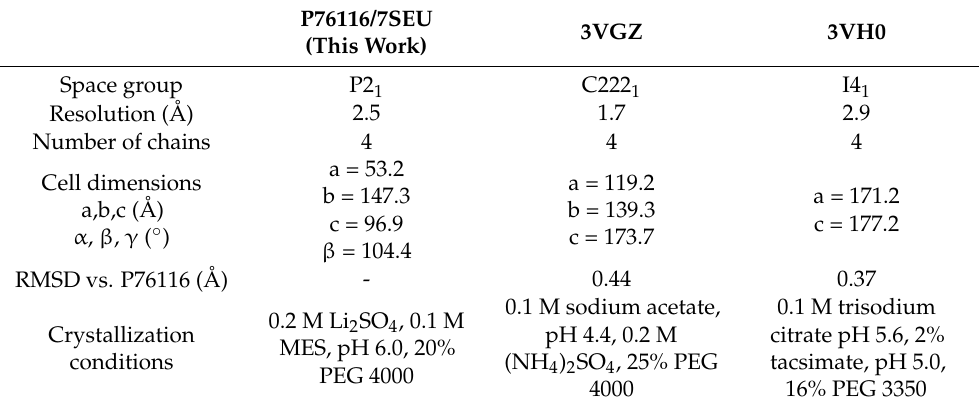
Table 2. Comparison of YncE/P76116 structure with PDB structures listed under UNIPROT entry